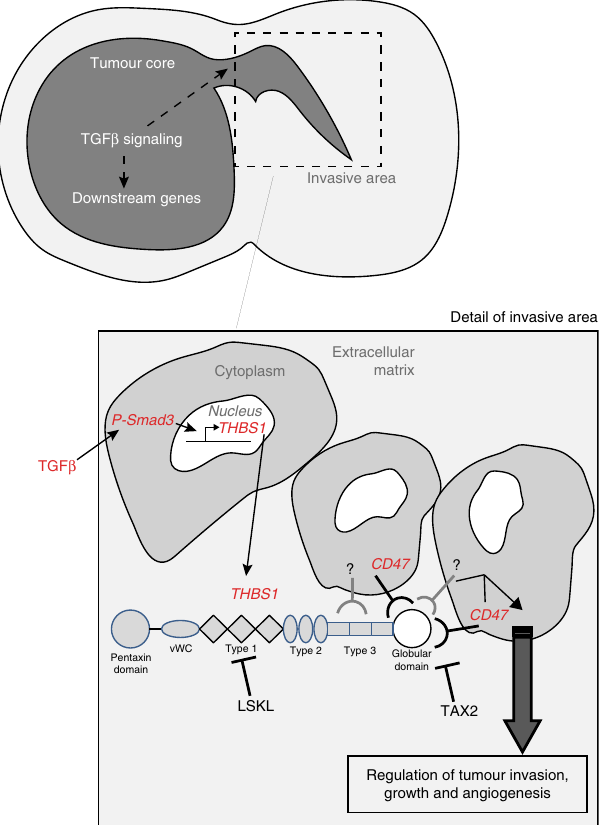
Fig. 8 Proposed model for GBM invasion TGF β 1 is expressed in both the core and the invasive areas in GBM. THBS1 is transcriptionally regulated via SMAD3, which binds to regulatory elements in the THBS1 gene. THBS1 will then be released and act on tumour cell invasion and expansion. The interaction with CD47 is critical in this and single reads. The genomic alignment was performed with Bowtie2 47 with default parameters on the same reference genomes as used for Xenome. Reads with quality mapping score lower than 10 were discarded. Differential expression between the tumour core and invasive areas: We fi rst assigned reads to hg38 (human) and mm10 (mouse) gene models retrieved from 48 . Using the R packages GenomicFeatures and GenomicAlignments 49 , 25,446 and 24,423 genes were analysed in human and mouse respectively. In order to compute differential expression, we performed two-class comparisons between tumour core and invasive samples using the R package DESeq2 50 . Differentially expressed genes were de fi ned by using an upper threshold on the P -value of 0.01 after correction for multiple testing using the method of Benjamini and Hochberg 51 .